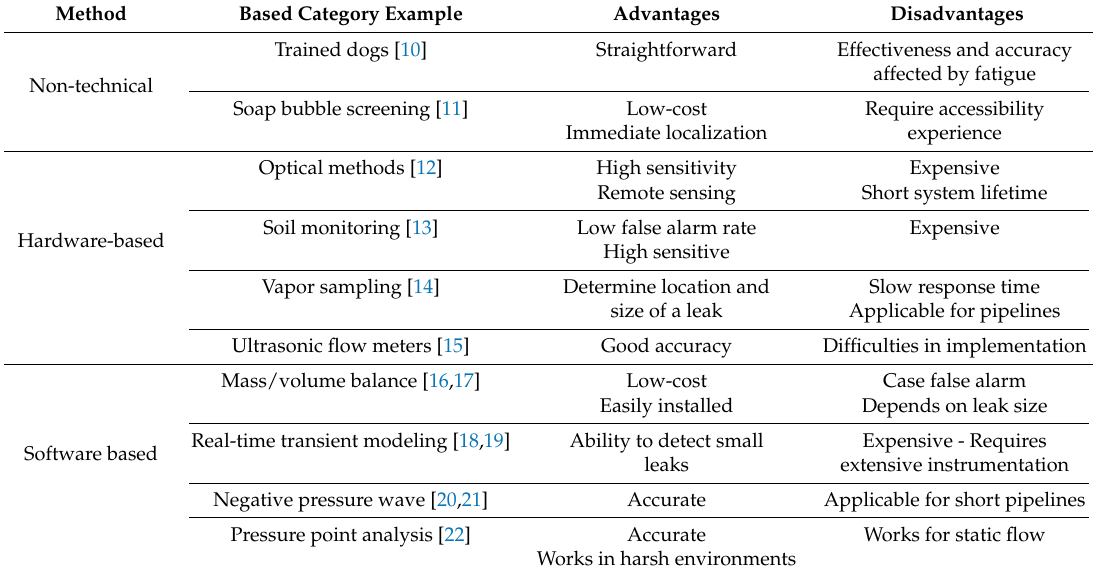
Table 1. Examples of leak detection methods often used, with a summary advantages and